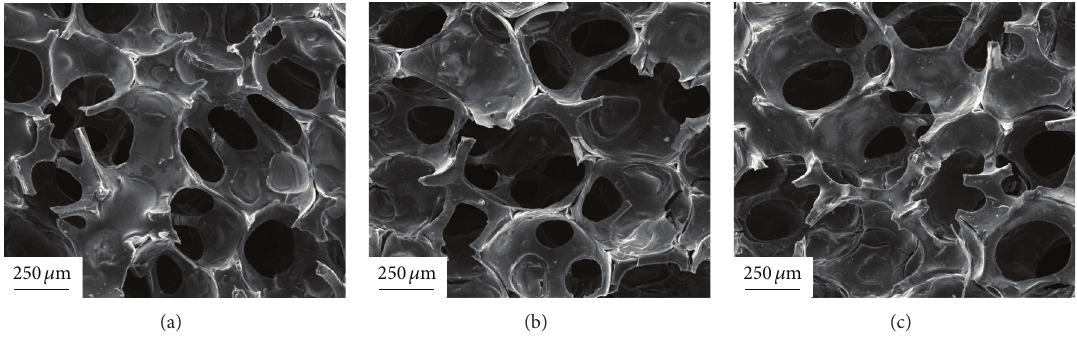
Figure 2: SEM images of the 0Fe-MBG/C (a), 5Fe-MBG/C (b), and 10Fe-MBG/C (c) composite scaffolds.